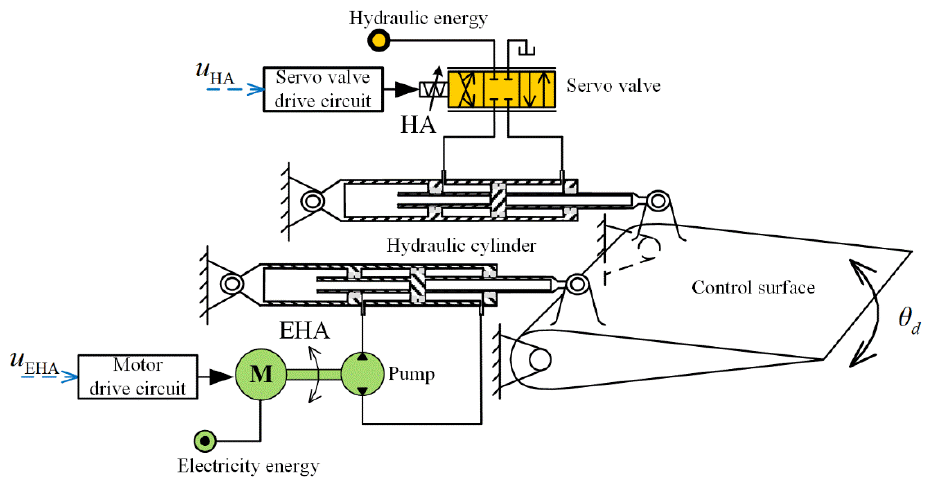
Figure 1. Dissimilar redundancy actuation